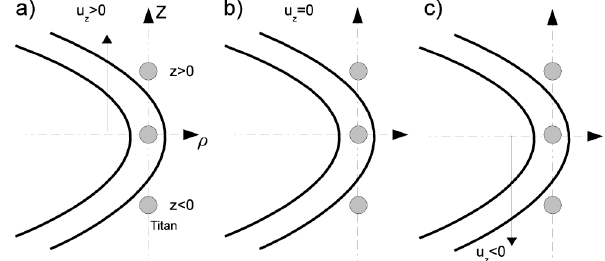
Fig. 1. Diagram illustrating the theoretical picture used in this pa- per. The solid curves indicate magnetic field lines around a current sheet in the z = 0 plane. The ( z,ρ) coordinates indicate a conve- nient “sheet coordinate system”. Panel (a) shows the sheet moving upwards, (b) the sheet at rest, (c) the sheet moving downwards. In each case Titan (the grey circle) may be located above the sheet, near the centre of the sheet, or below the sheet. For example, the bottom circle in panel (b) would indicate Titan located below the sheet and the sheet at rest with respect to Titan. As a second exam- ple, the top circle in panel (a) would indicate Titan located above the sheet but with the sheet moving up to meet Titan, so Titan will shortly pass through the centre of the sheet.